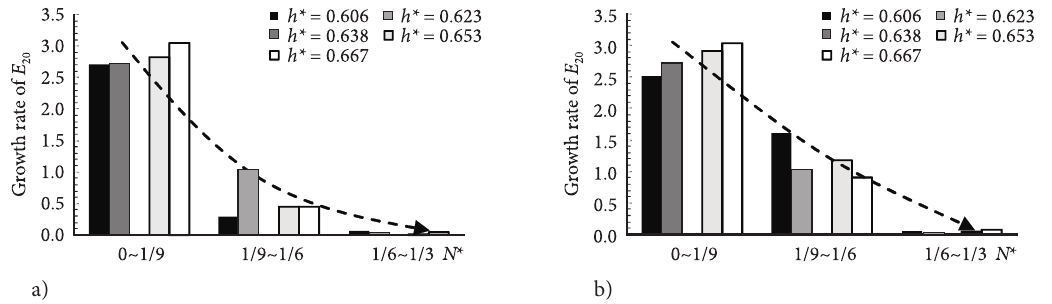
Fig. 9. Growth rate of E with N * when Q = 0.4 l/s in: (a) parallel flashboard spillways; (b) interlaced flashboard 20